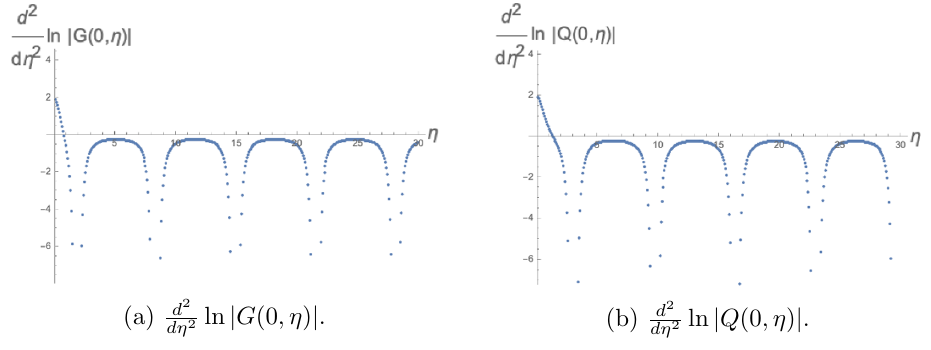
Figure 7 . Plots of d 2